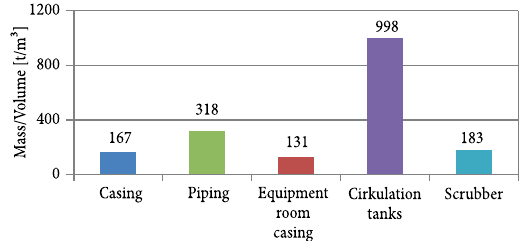
Fig. 5. Scrubber system specific mass